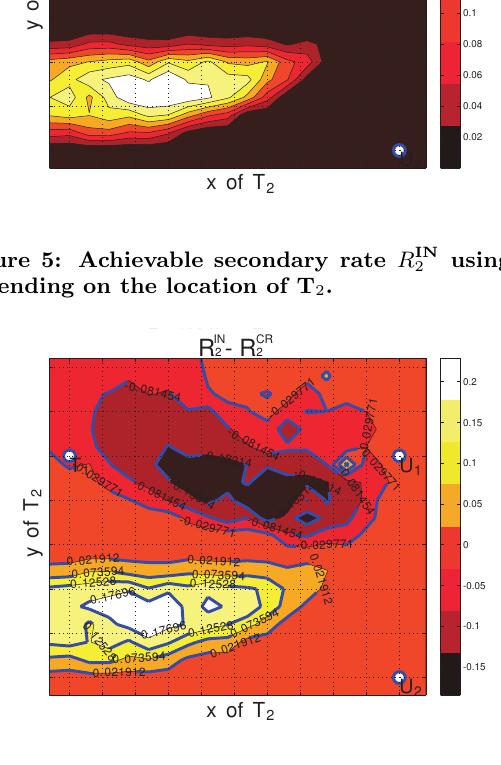
CR between the CR and 2 − R 2